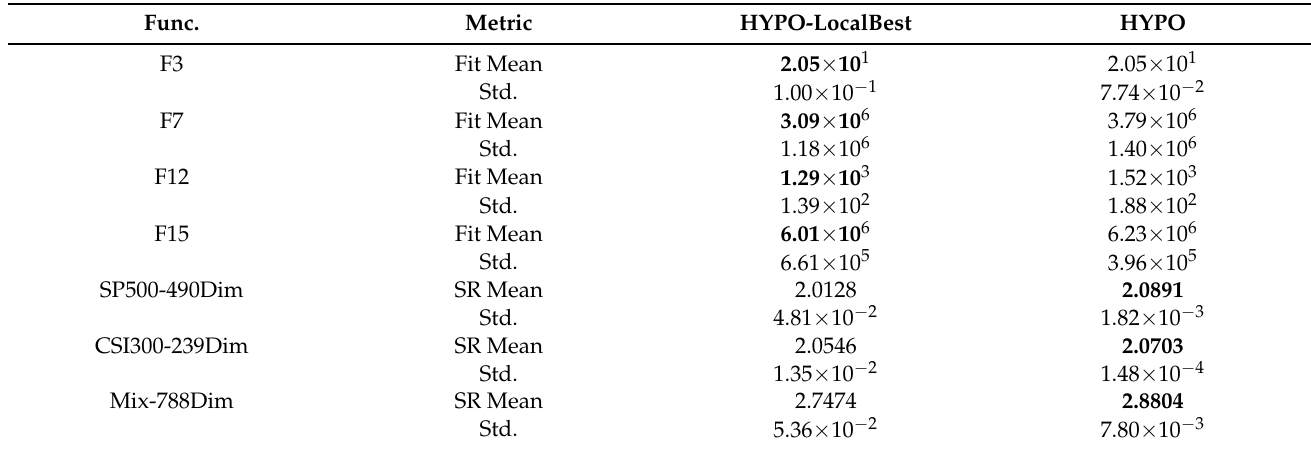
Table 10. Comparative Results on Different Types of Information being